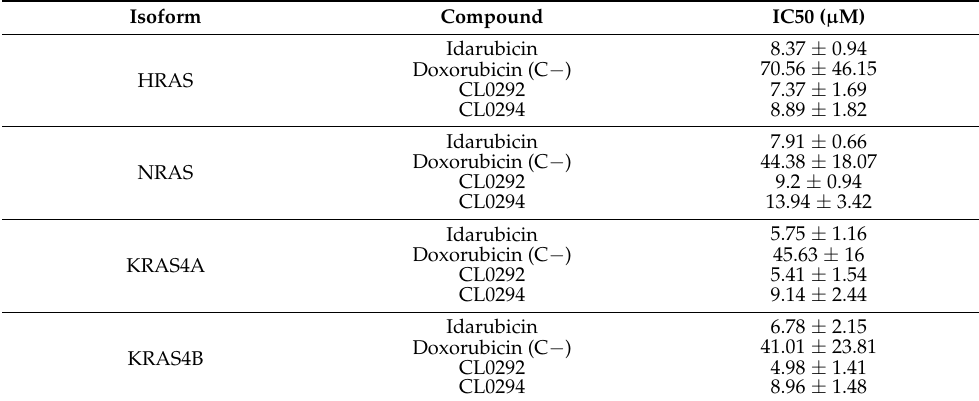
Table 1. IC50 for RAS